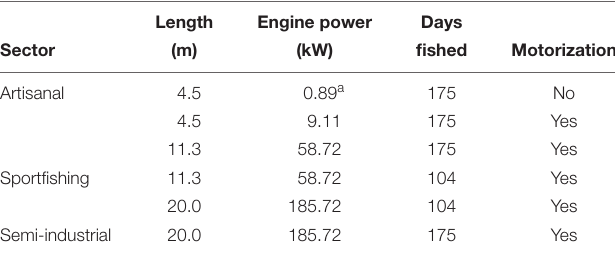
TABLE 1 | Fishing capacity of the artisanal, recreational sportfishing, and semi-industrial fishing sectors of the Republic of